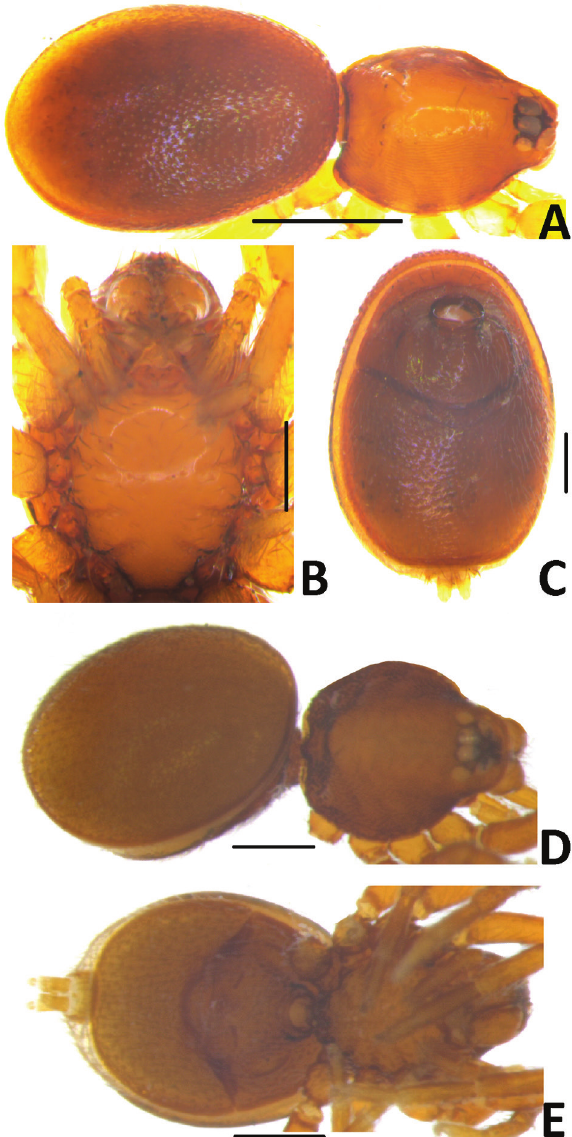
Figure 19. Silhouettella snippy n. sp., female from NIFS Arbo- retum ( A–C ), Silhouettella tiggy n. sp. female from Dunuma- dalawa FR ( D–E ): A , habitus, dorsal view; B , sternum, ven- tral view; C , abdomen, ventral view; D , habitus, dorsal view; E , habitus, ventral view. Scale bars: 0.5 mm ( A ), 0.2 mm ( B–E